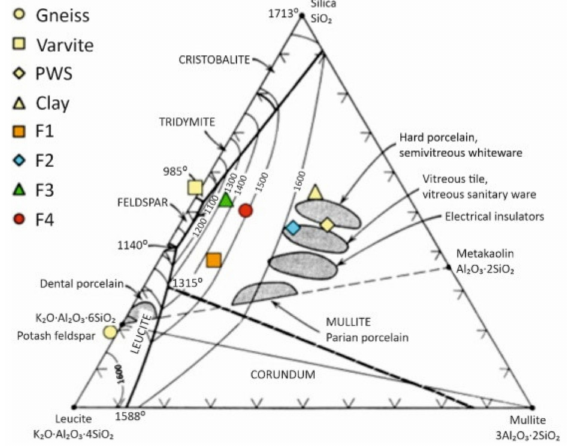
Figure 11. Leucite–silica–mullite diagram, showing typical commercial porcelain composition ranges and the location of the compositions of gneiss and varvite wastes and the formulations investi- gated